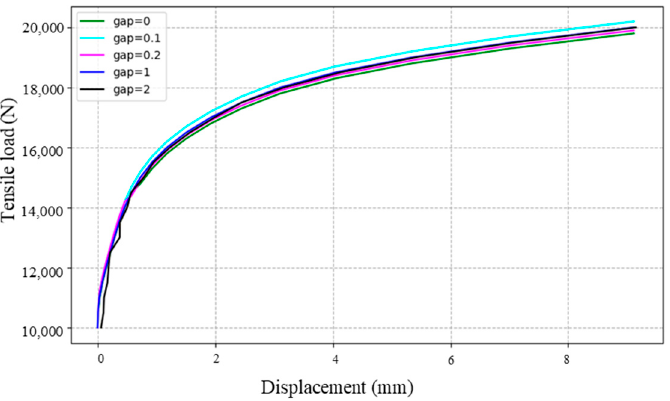
Figure 19. Load displacement curves for strap sheet joints with different gaps.